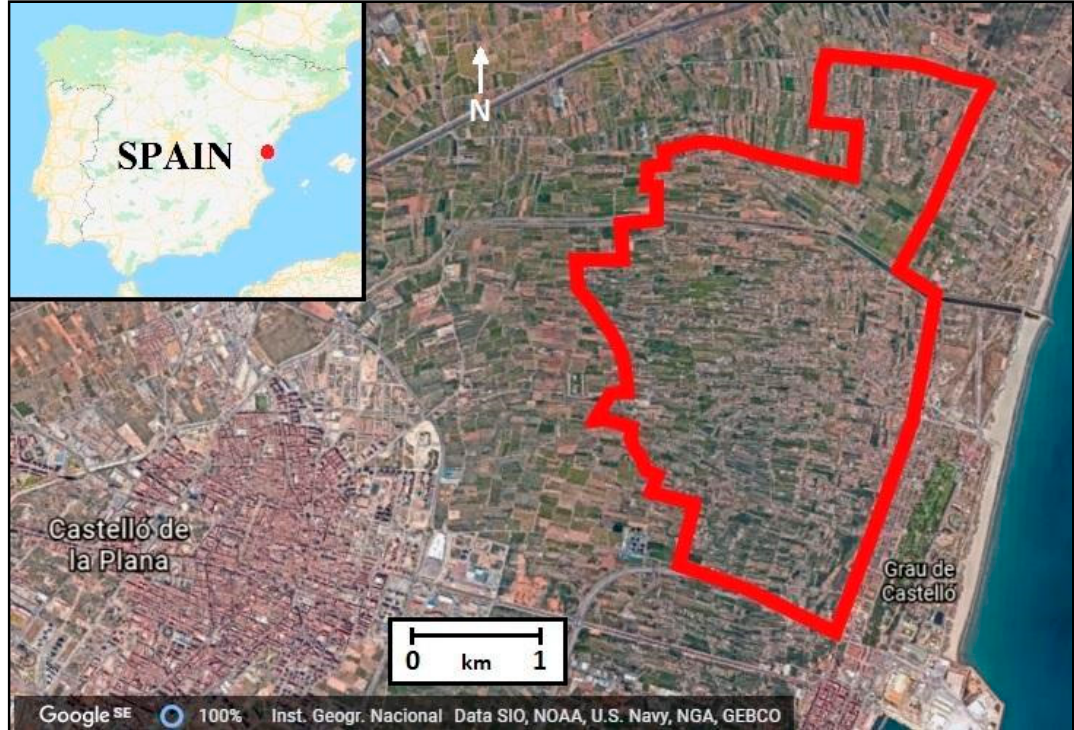
Figure 1. Location of the La Marjaleria study area in the municipality of Castelló de la Plana, Spain.